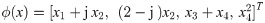
CGS process of systems (12) and (13) with respect to the given complex map vector.ϕ(x)=[x1+j x2,  (2−j )x2, x3+x4, x42]T. (a) x1,r − x2,i, y1,r; (b) x1r − x2,r, y1,i; (c) 2x2,r+x2,i, y2,r; (d) 2x2,i − x2,r, y2,i; (e) x3+x4, y3; (f)x42, y4